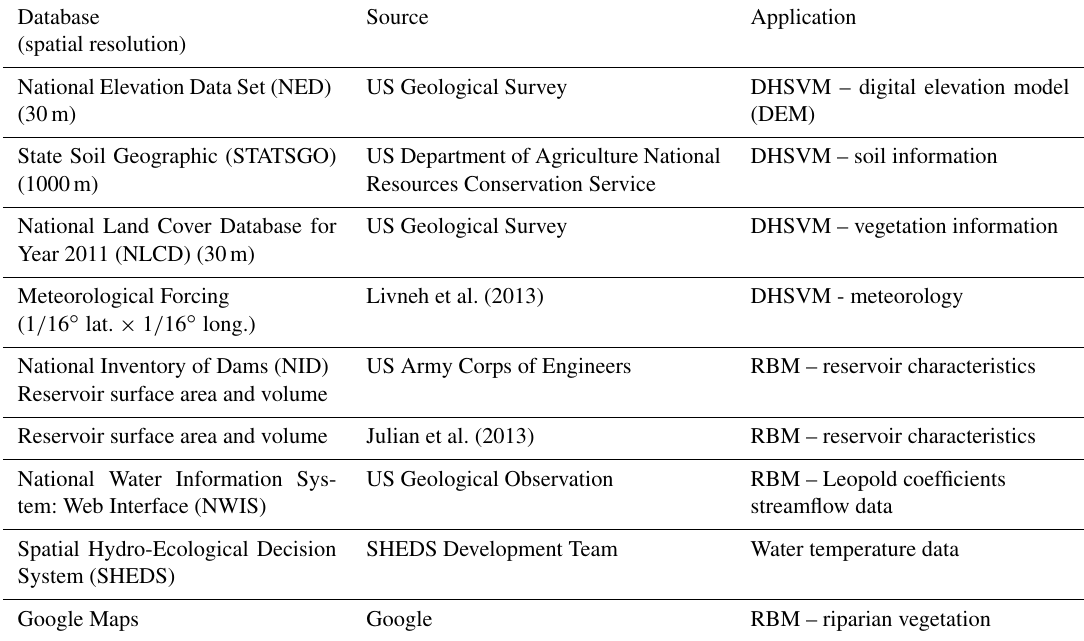
Table 2. Datasets and sources used for estimating parameters in the model identification